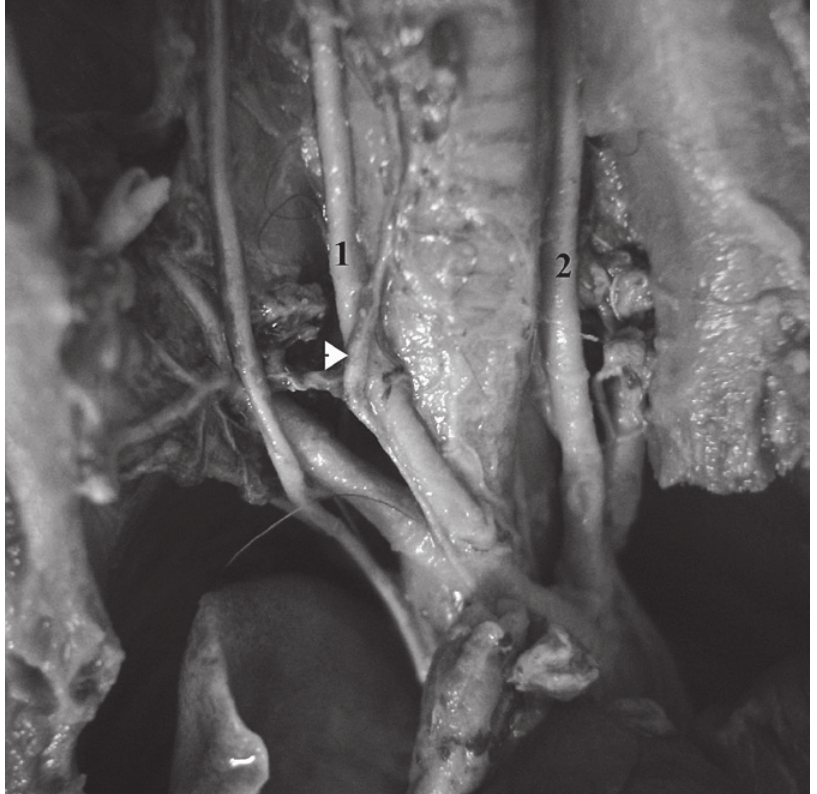
Fig 2 - Photomacrography of Saguinus niger sympathetic trunk in ventral view demonstrating a stellate ganglion (arrowhead), right (1) and left (2) common carotid